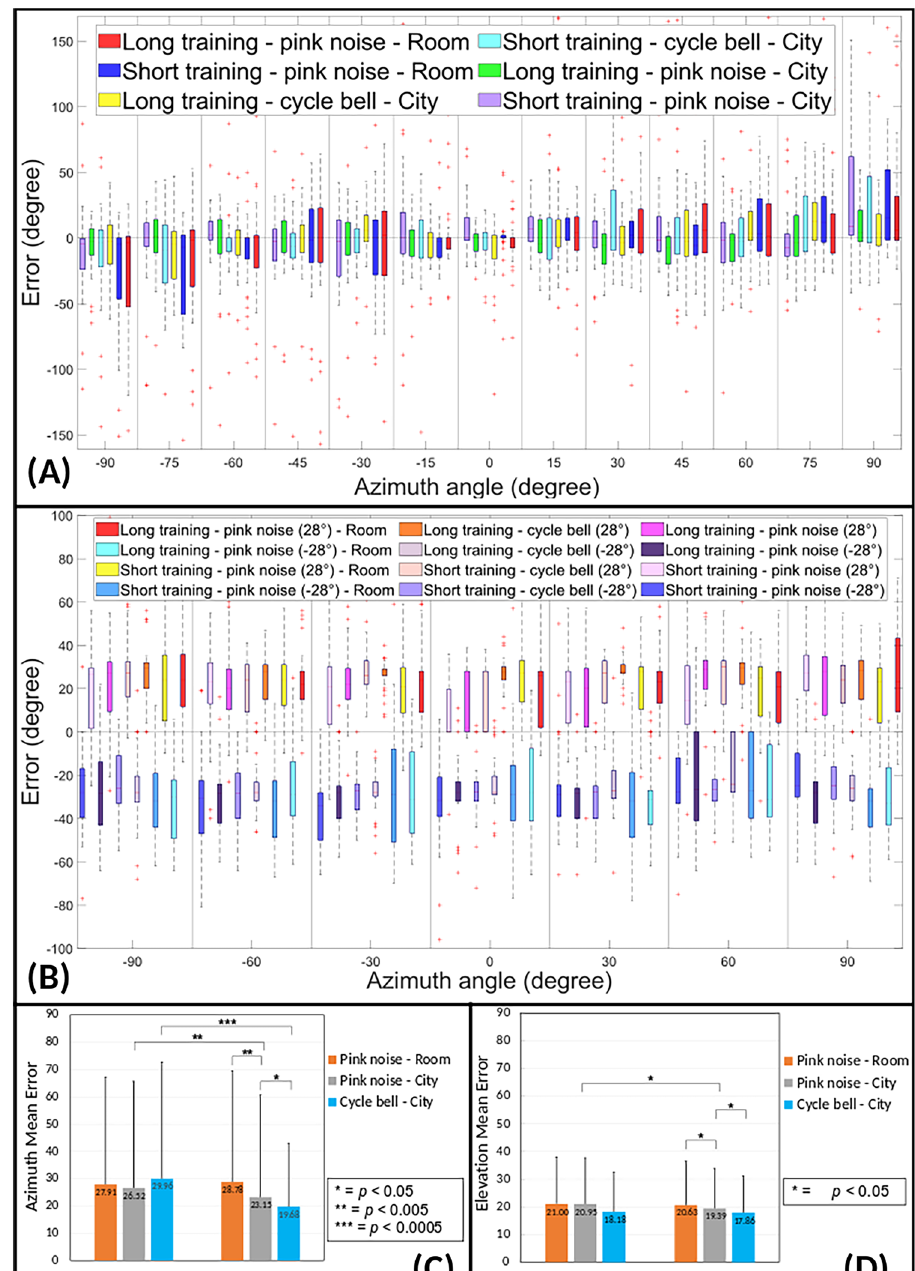
Figure 3. Box-plots showing errors in azimuth and elevation. ( A ) Angle-by-angle comparison of error observed in azimuth (horizontal plane). Includes all six studies together. ‘Error’ from the vertical axis is obtained by subtracting ‘response position’ from ‘sound cue position.’ ( B ) Angle by angle comparison of error observed ◦ ◦ in elevation (vertical plane) for + 28 and − 28 . Includes all six studies together. ‘Error’ on the vertical axis is obtained by subtracting ‘response position’ from ‘sound cue position.’ ( C ) Comparison of azimuth mean error for all six conditions with the main distribution based on training, highlighting the statistical significance by comparing two conditions at a time with t-test statistical analysis. A single asterisk means the two variables are significantly different, a double-asterisk means the two variables are very significantly different, and three asterisks means the two variables are extremely significantly different. ( D ) Comparison of elevation mean error for all six studies grouped by training, highlighting the statistical significance by comparing two conditions at a time with t-test statistical analysis. A single asterisk means the two variables are significantly